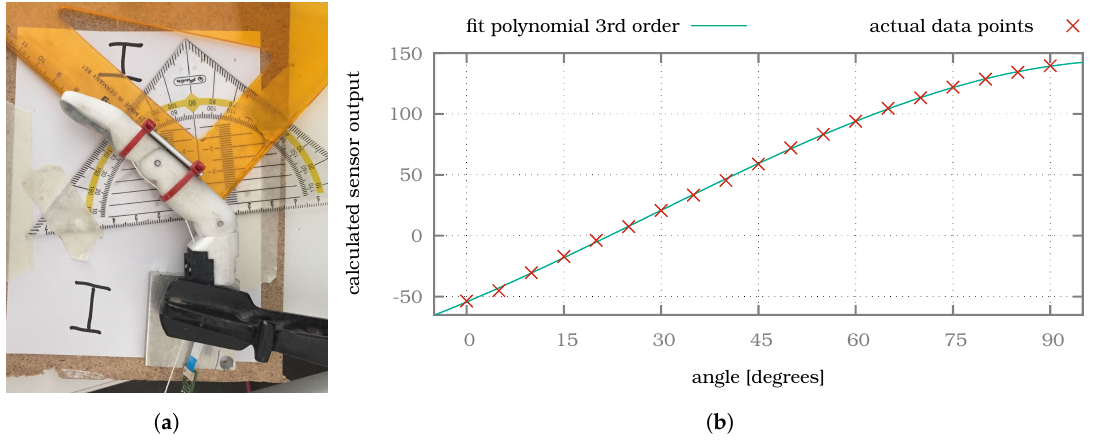
Figure 13. ( a ) The PIP joint is fixed and the MCP joint is incrementally rotated by 5 ◦ while the sensor output data are acquired, to determine the correlation between sensor output and actual rotation angle. ( b ) The resulting data points and 3rd order polynomial